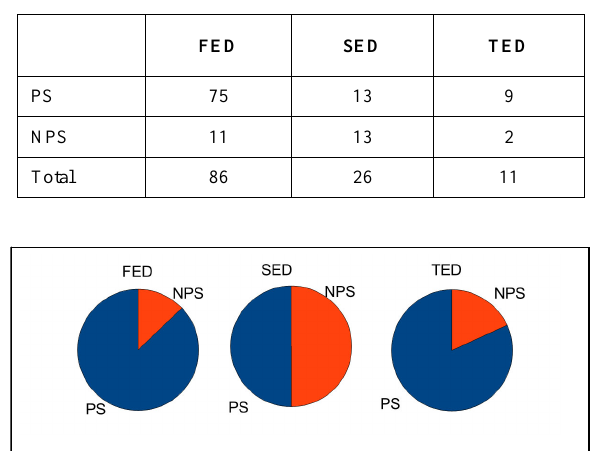
Figure 3. Results in the Course